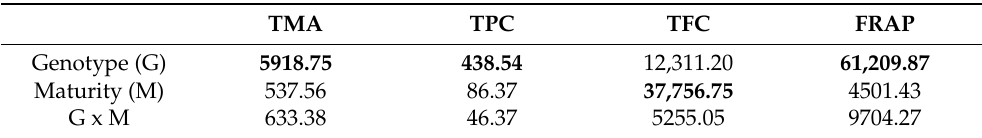
Table 5. ANOVA F-value summary of 4 most important nutraceutical traits of 7 genotypes at 4